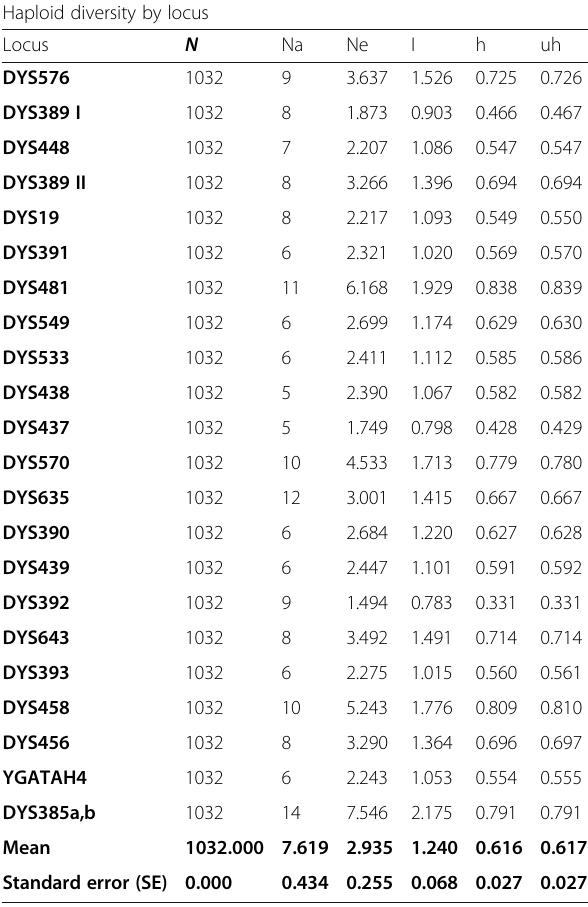
Table 2 Haploid Diversity by locus using PowerPlex® Y23 System Haploid diversity by locus Locus